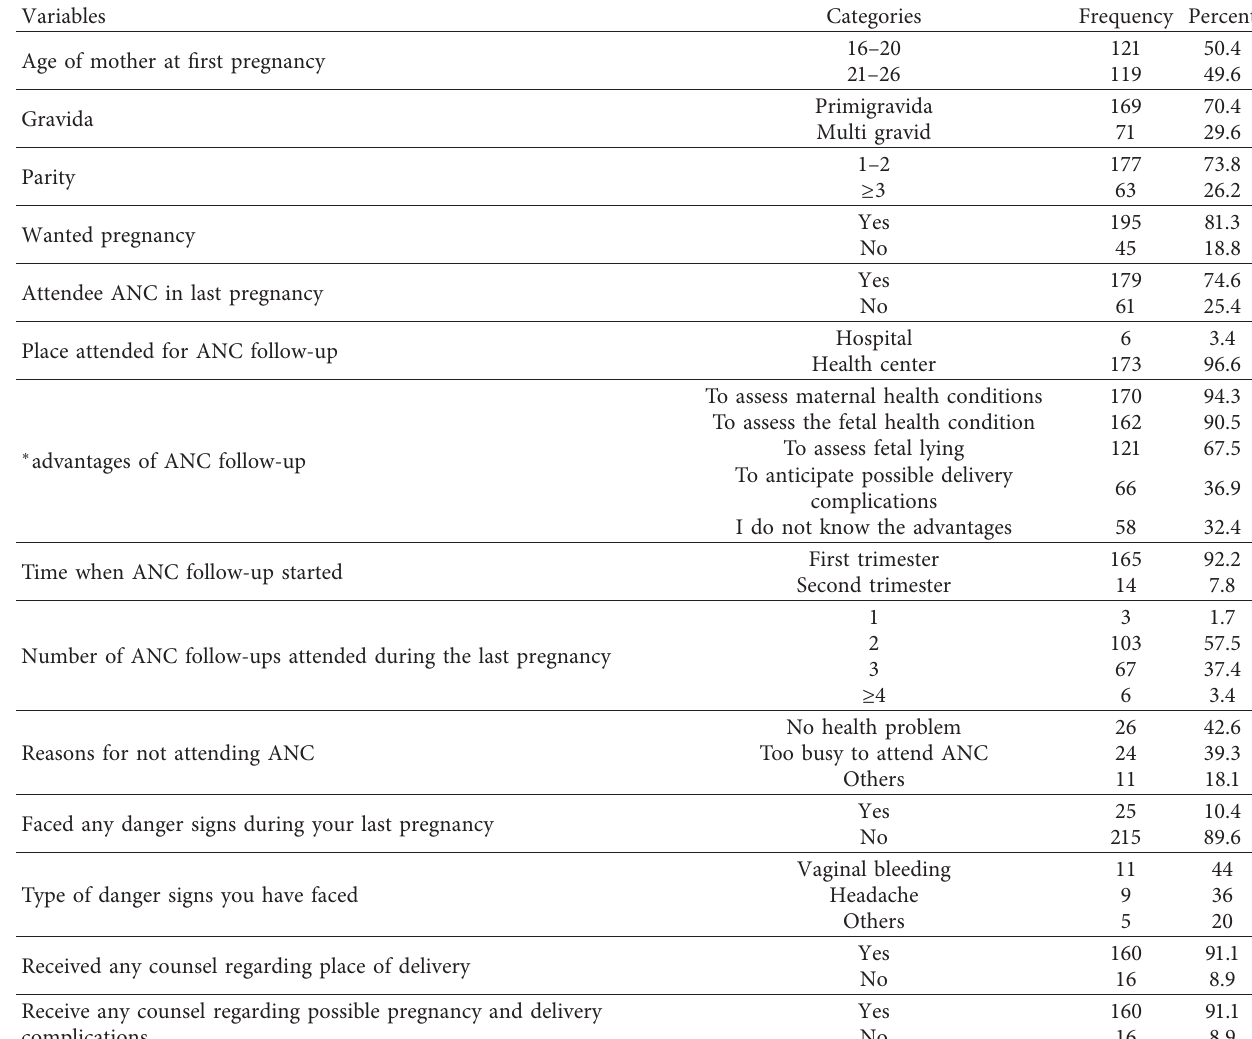
Table 2: Obstetric characteristics of women who gave birth in the last one year at Serbo, Kersa Woreda, Southwest Ethiopia, July 2021. Variables